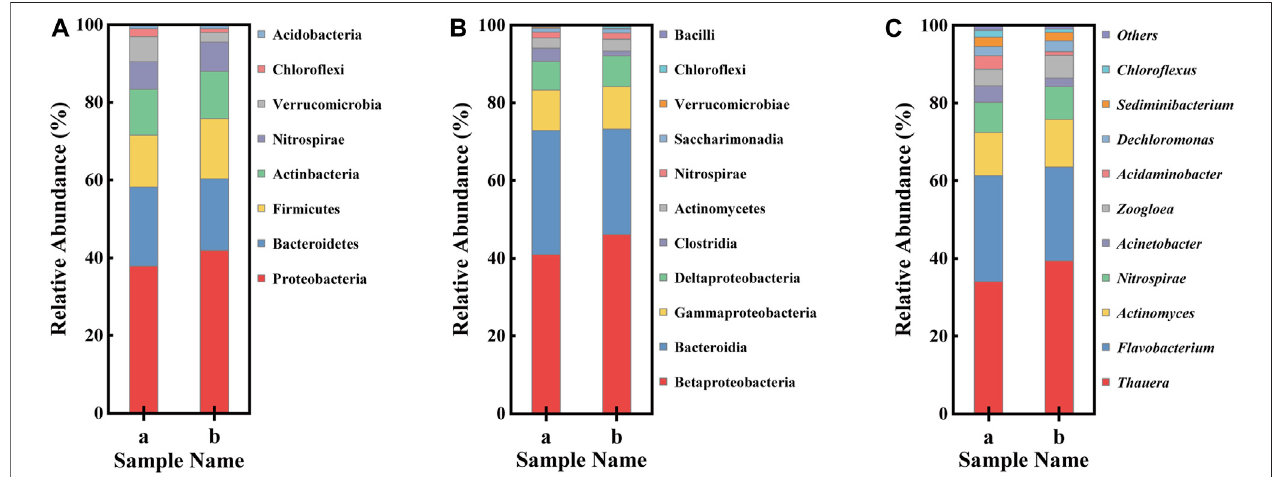
FIGURE 5 | Bar graph of bacterial populations of two samples [ (A) AS and (B) MAS] of the bio fi lm [ (A) Phylum, (B) class, and (C) genus].